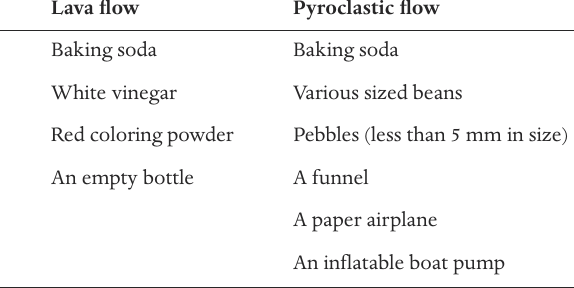
Table 1. Eruption simulation (materials